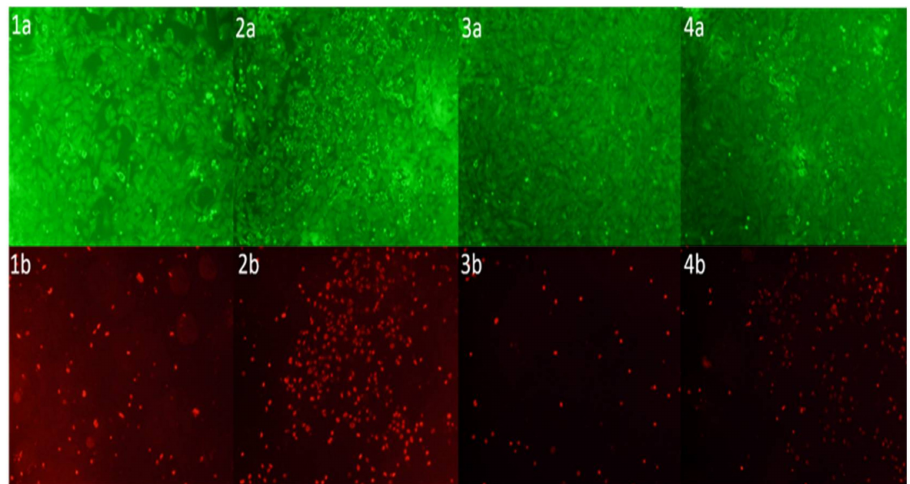
Figure 13. Live / Dead assay; pre-osteoblast cells were cultured in the presence of Ti foil sca ff olds: (1 a , b ) CS, (2 a , b ) HNTs-CS, (3 a , b ) ZnHNTs-CS, and (4 a,b ) GS-ZnHNTs-CS. Live cells (green) and dead cells (red). ZnHNTs led to increased cellular viability.